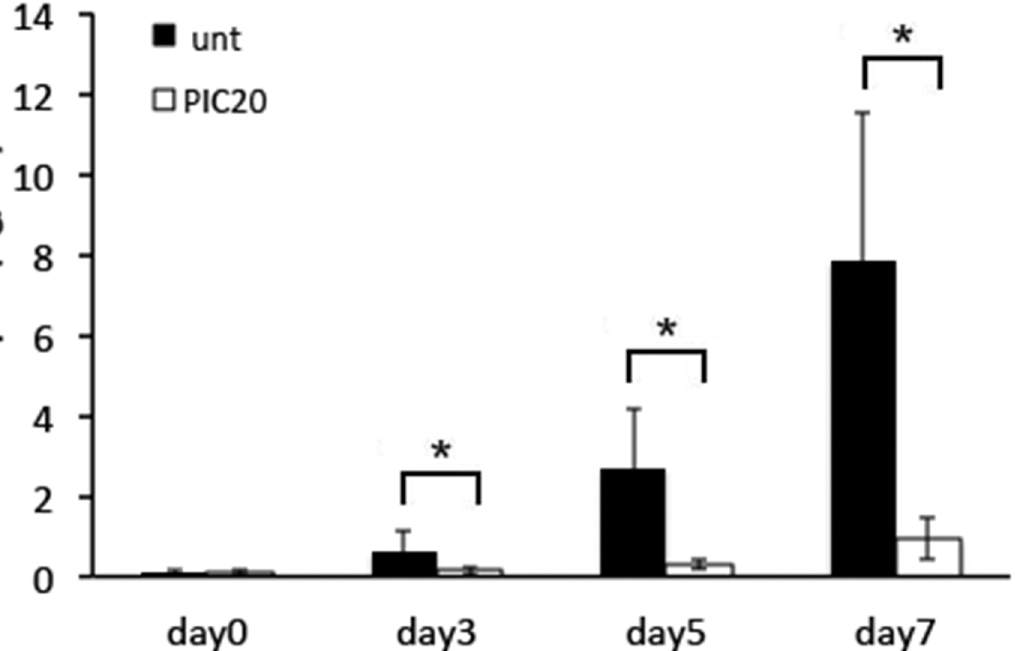
Fig 4. Poly (I:C) decreases HIV-1 replication in PBMCs. HIV-1 p24 levels (ng/ml) in HIV-1 infected PBMCs left untreated or treated with poly (I:C) at 20 μ g/ ml were measured after washing the residual input virus (day 0), and again on days 3, 5 and 7 after infection. Results are shown as the mean ± STDEV from three experiments with each condition tested in triplicate. * p = 0.008, p = 0.01 and p = 0.009 for days 3, 5 and 7 after infection between untreated and poly (I: C) treated